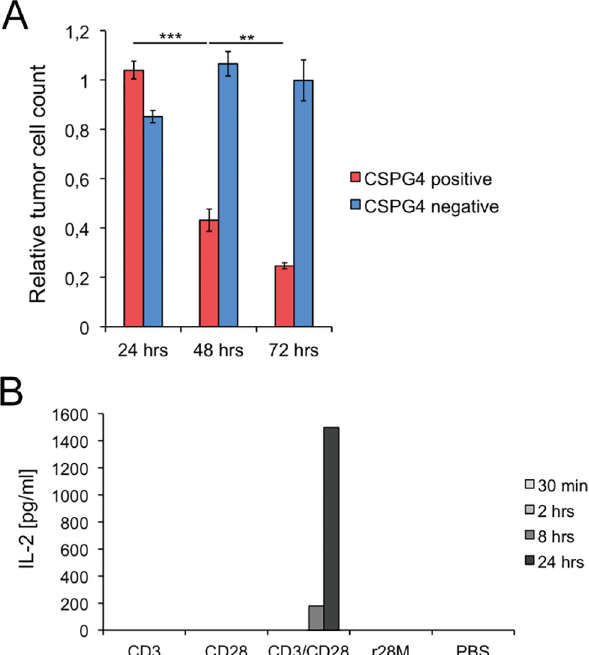
Fig 2. Specificity and time dependence of the biological activity of r28M. (A) CSPG4 positive (IPC-298) or negative cells (U-251 MG) were incubated together with PBMC and 1000 ng/ml enriched r28M fraction in a final volume of 150 μ l for 24, 48 as well as 72 hrs to measure tumor cell viability. Results show samples normalized to the controls. Cells incubated without r28M served as controls and their number was considered as 1. Values are means ± SE. Significance levels: x: p (cid:1) 0.05; xx: p (cid:1) 0.01; xxx: p (cid:1) 0.001. (B) Plates were coated with the indicated antibodies or PBS and incubated with PBMC for 30 min, 2 hrs, 8 hrs as well as 24 hrs, respectively. Preparations were pipetted in triplicates. The supernatants of these triplicates were pooled and the IL-2 concentrations were measured by